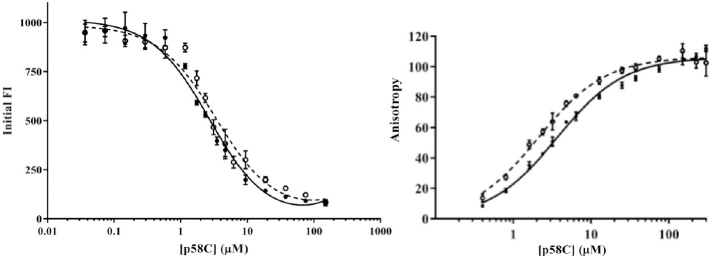
Fig 6. The two p58C constructs bind a RNA-primed substrate with the same affinity. Left: The p58C 272-464 (filled circle, solid line) and p58C 266-464 (open circle, dashed line) proteins were titrated into Cy5-labeled substrate in a buffer containing 20 mM MES (pH 6.5), 50 mM NaCl, 2 mM DTT, and 0.05% Tween. FI was measured at 25˚C. RNA: 5’- GGCUCGGA-3’ ; DNA: 5’-Cy5-AAACTCCGAGCCAACATA-3’ . Right: The p58C 272-464 (filled circle, solid line) and p58C 266-464 (open circle, dashed line) proteins were titrated into 6FAM-labeled substrate in a buffer containing 20 mM MES (pH 6.5), 50 mM NaCl, and 2 mM DTT. Fluorescence anisotropy was measured at 25˚C. RNA: 5’-GGACCTCCA GGA-3’ ; DNA: 5’-6FAM-AAACTCCTGGAGGTCCAACATA-3’ . For both panels, error bars represent the standard deviation of three replicates.